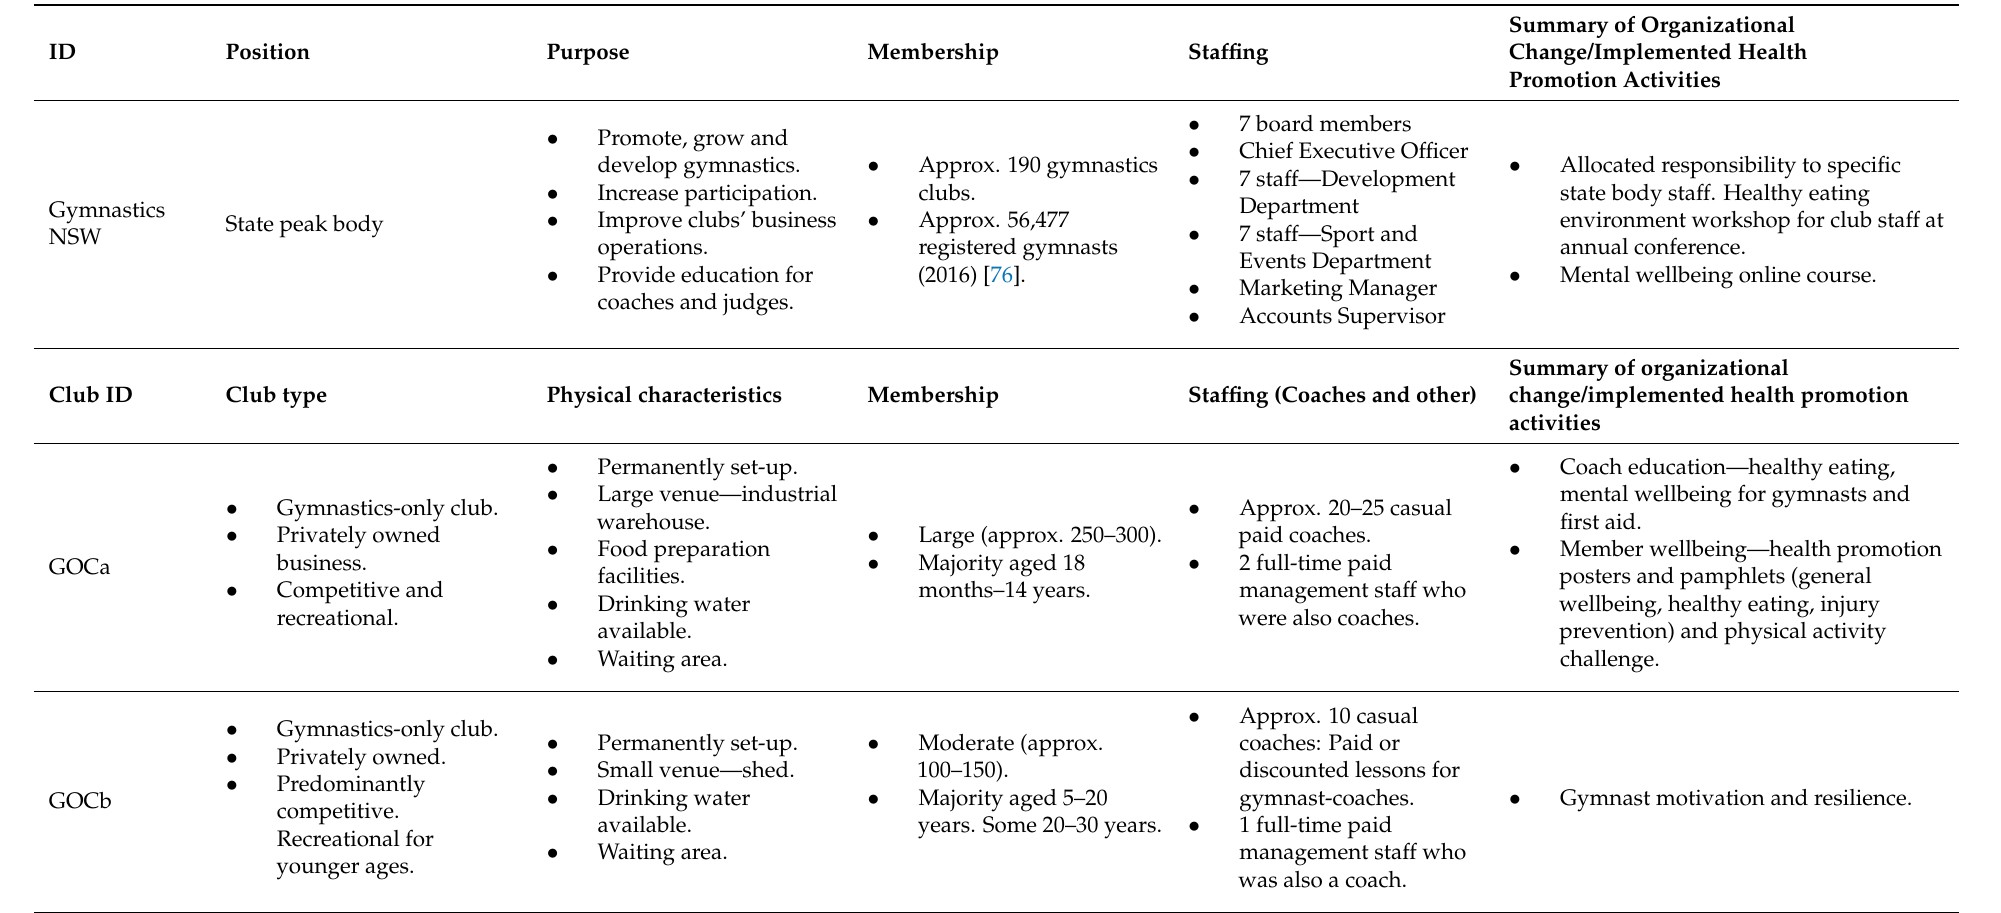
Table 1. Characteristics of participating gymnastics